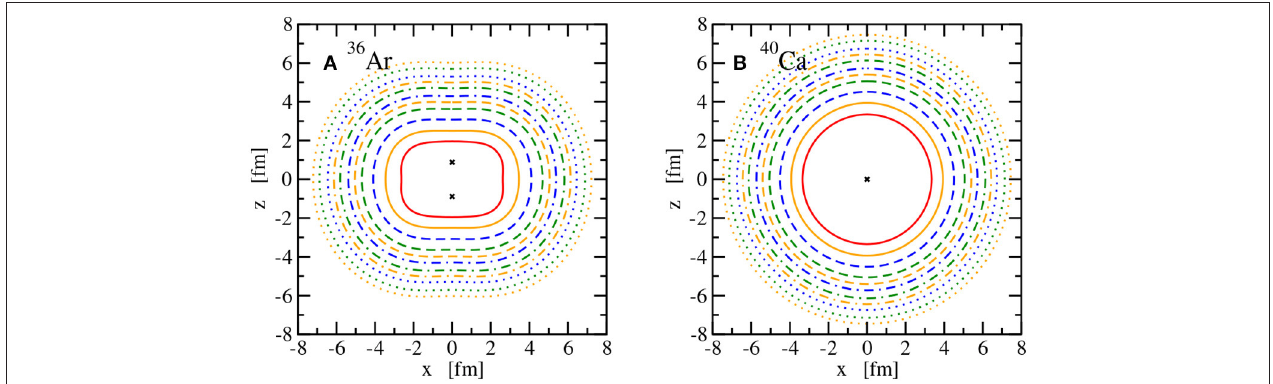
FIGURE 11 | Lines of constant intrinsic matter density ρ of the nuclei 36 Ar (A) and 40 Ca (B) . See Figure 8 for the legend. Points of maximum density are indicated with a ×